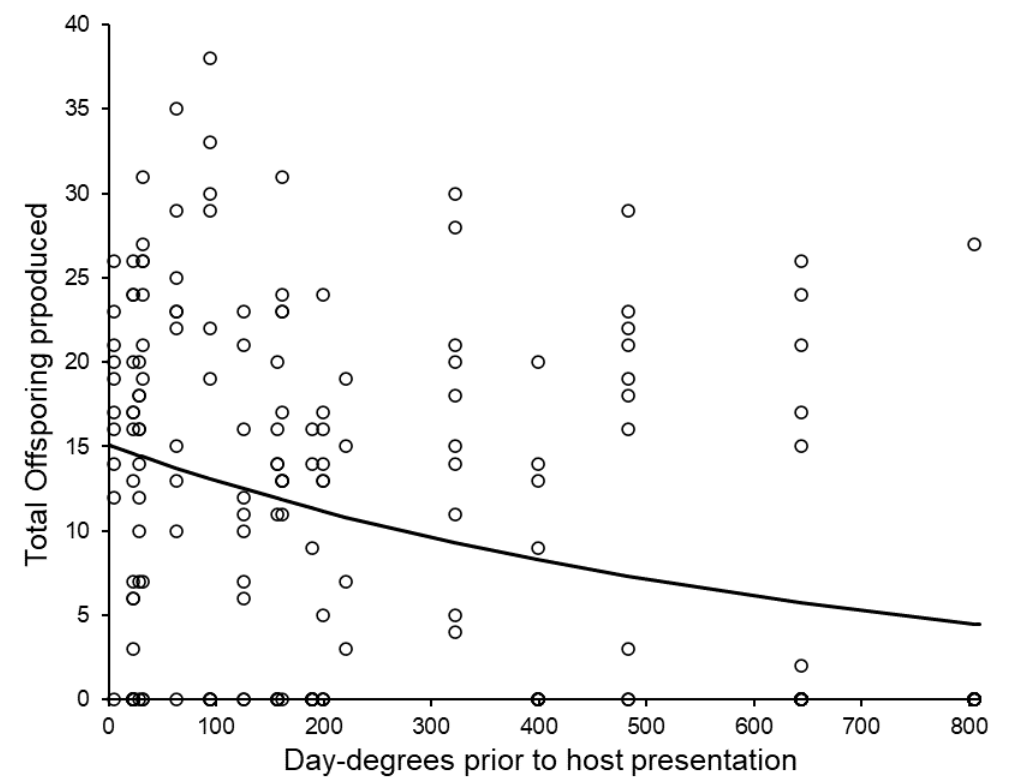
Figure 6. The total number of offspring produced by groups of females according to the number of day-degrees accumulated during storage. The curve was fitted using log-linear regression (Offspring produced = antiLog e (( − 0.001504 × Day-degrees) + 2.7146). Table 6. Adult offspring production according to storage